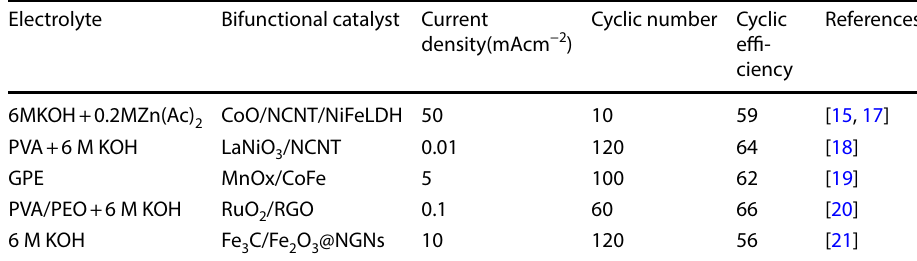
Table 2 The redox reactions of RZAB battery during discharging and charging process